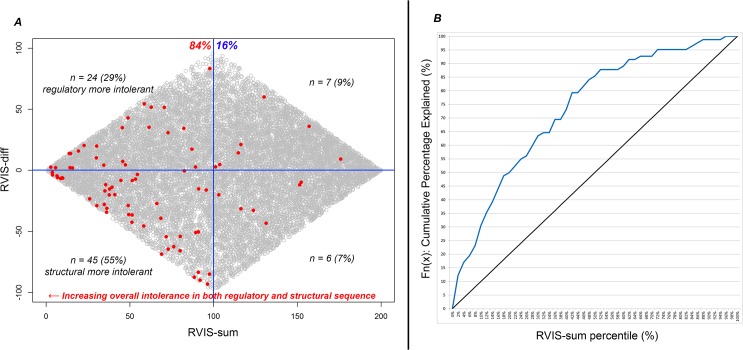
(A) Scatterplot of RVIS-sum (RVIS-CHGV + ncRVIS) and RVIS-diff (RVIS-CHGV–ncRVIS) scores. Each dot represents a gene. The grey dots represent the background genome-wide distribution. The red dots highlight the 82 OMIM haploinsufficiency genes with reported causal de novo mutations. A higher (positive Y-axis value) RVIS-diff score indicates genes where we might have a greater expectation of gene dosage aberrations being important compared with protein structure aberrations. A lower RVIS-sum (X-axis value) highlights genes that are increasingly intolerant in both their noncoding and protein-coding sequence. (B) A cumulative percentage plot for the RVIS-sum percentile accommodating the 82 OMIM halpoinsufficiency genes.At any given point on the X-axis (RVIS-sum percentile) we can determine what percentage of the 82 OMIM haploinsufficiency genes are accounted for.